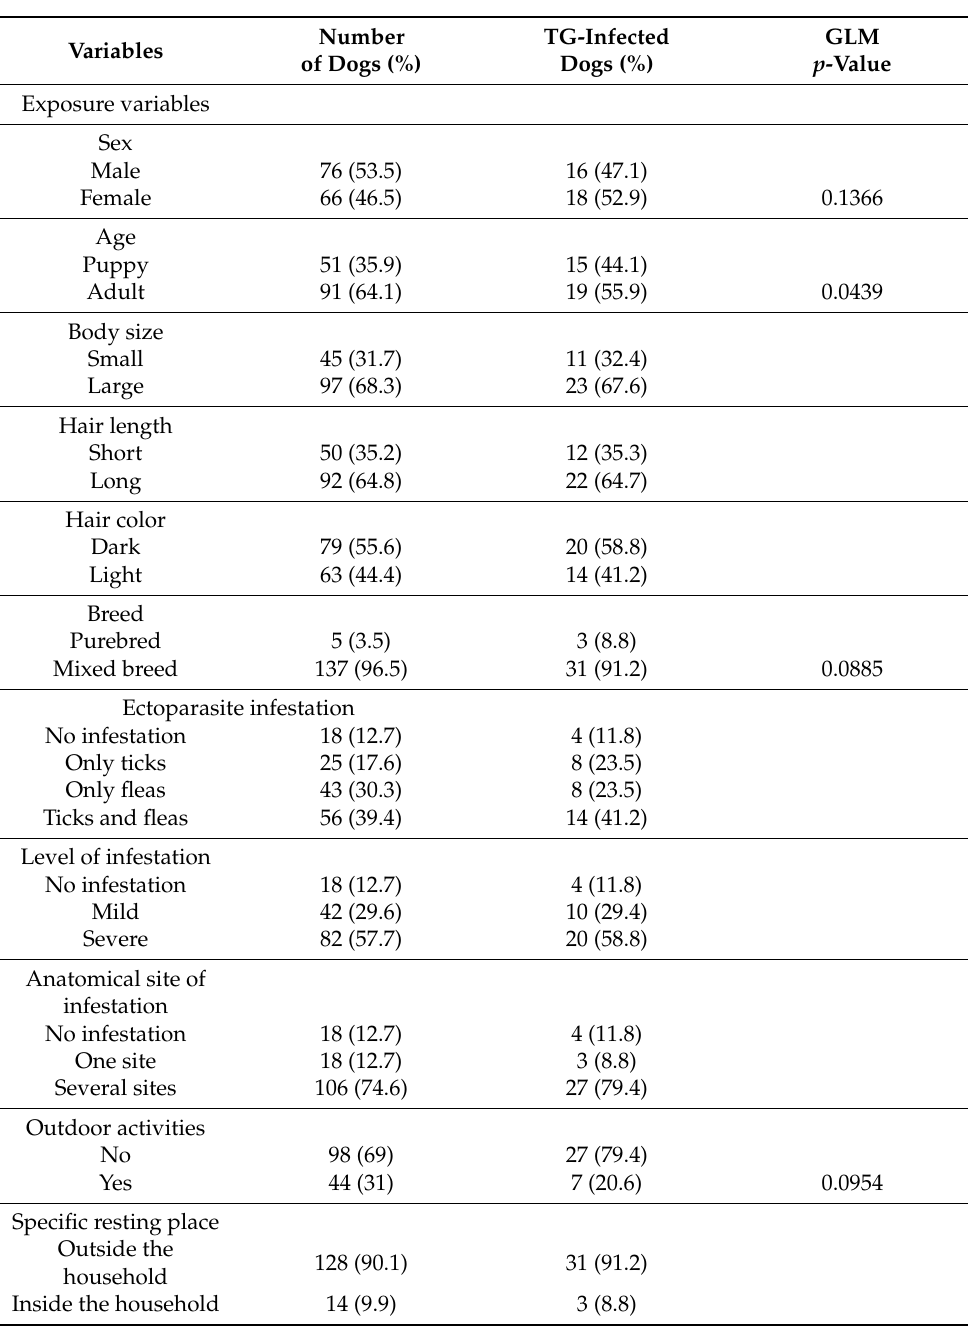
Table 1. Frequency of typhus group (TG) Rickettsia detected by semi-nested polymerase chain reaction ( Sca5 gene) relative to clinical and exposure variables of dogs from Maxcan ú , Yucatan, Mexico, and their resulting p -values from the generalized linear model (GLM) with backward stepwise selection of variables fitted for the association